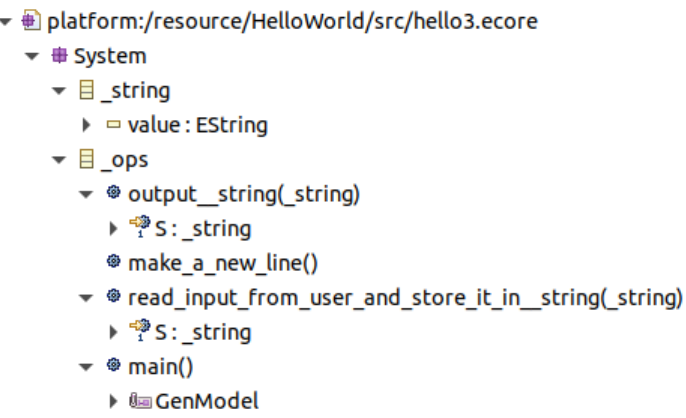
Figure 4. Ecore model compiled from the REX text in the “Hello, World! 3”